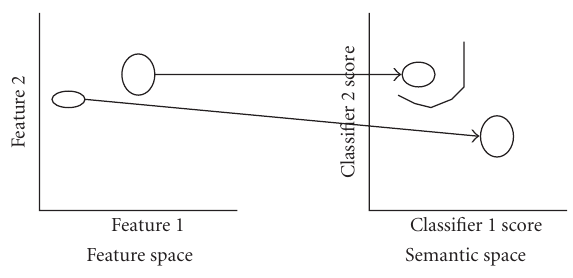
Figure 4: Illustration of SVM for